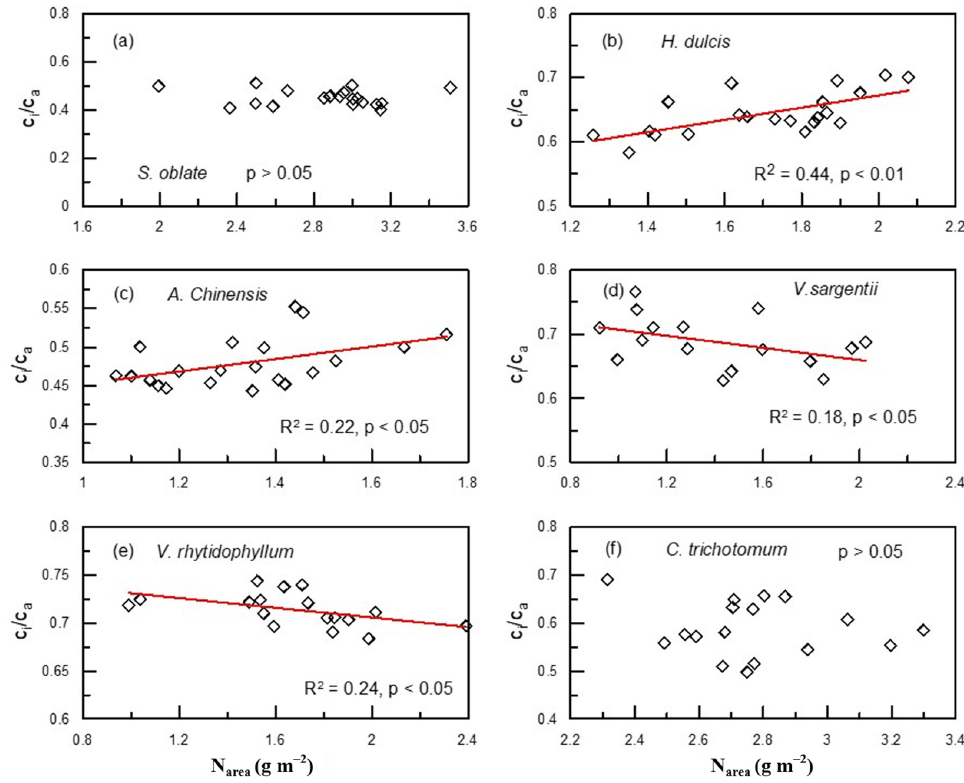
Figure 6. Relationships between leaf N based on area (N area ) and the ratio of intercellular to ambient CO 2 concentration (c i /c a ) at plant individual level for plants derived from the third sampling cam- paign: ( a ) S.oblate , ( b ) H. dulcis , ( c ) A. chinensis , ( d ) V.sargentii , ( e ) V. rhytidophyllum , ( f ) C. trichotomum .